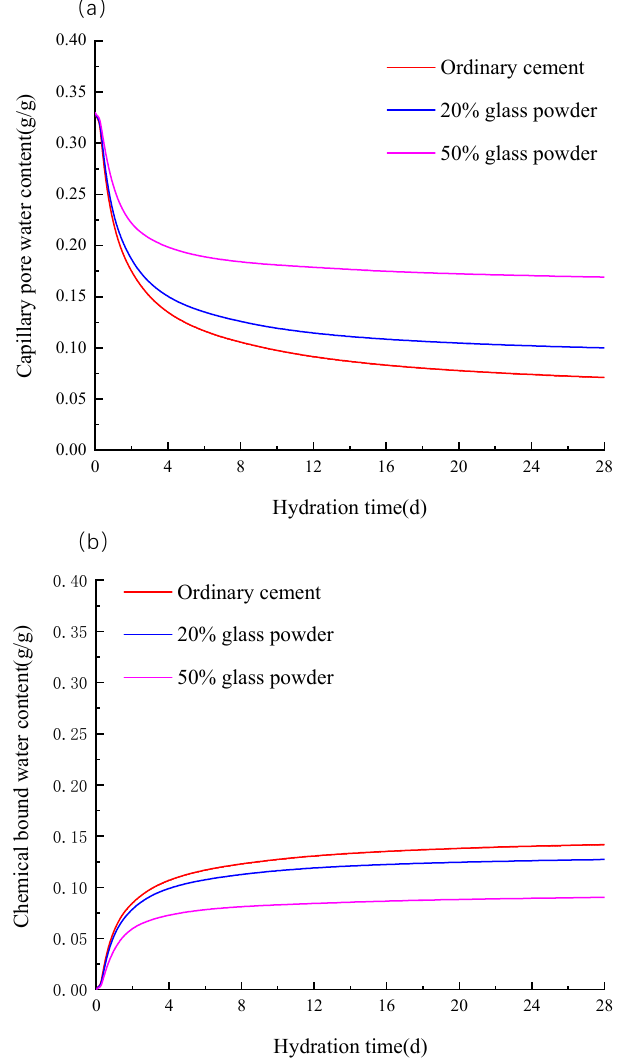
Figure 5. Evolution curve of capillary water and chemically combined water with hydration time. ( a ) capillary water ( b ) chemically combined water.